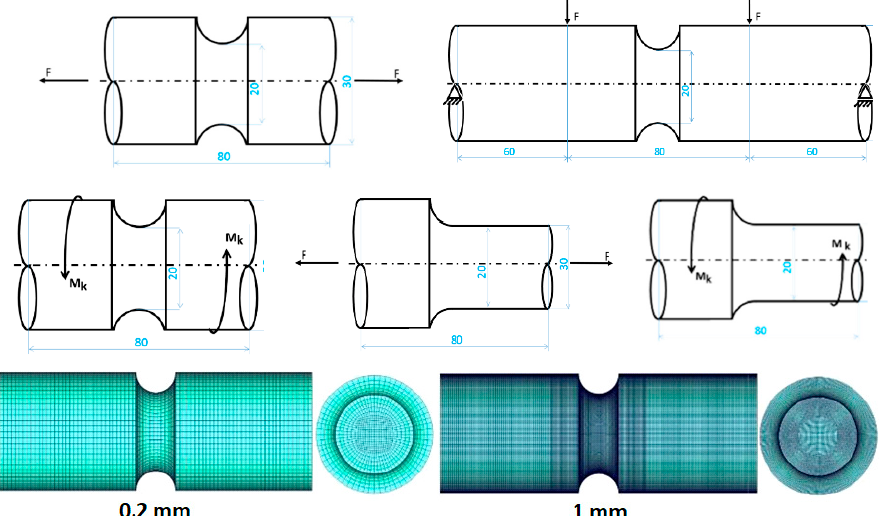
Figure 5. Cases of notched 3D components (dimensions are in millimeters) and the formation of a mesh of elements for a shaft with a semicircular circumferential groove (element length 1.0 mm and 0.2 mm).